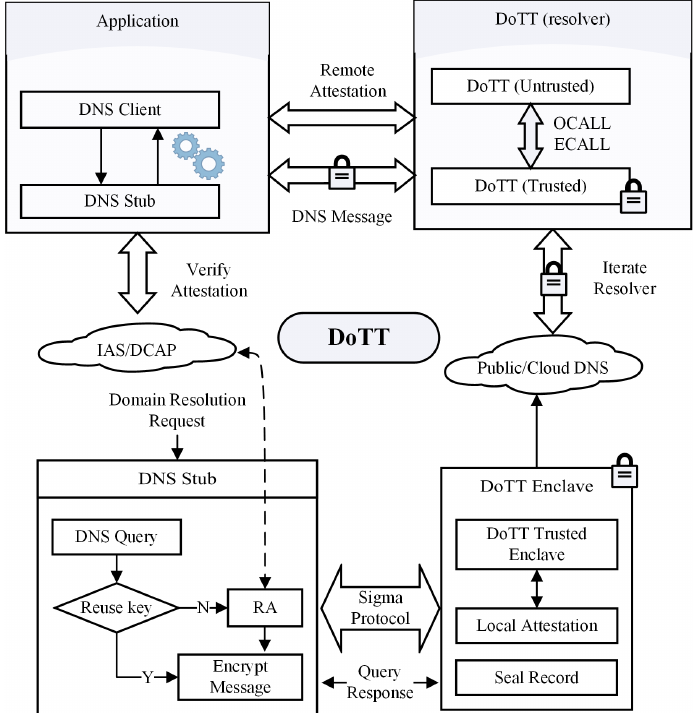
Figure 1. DoTT: The privacy enhancement framework for DNS based on TEE (Intel